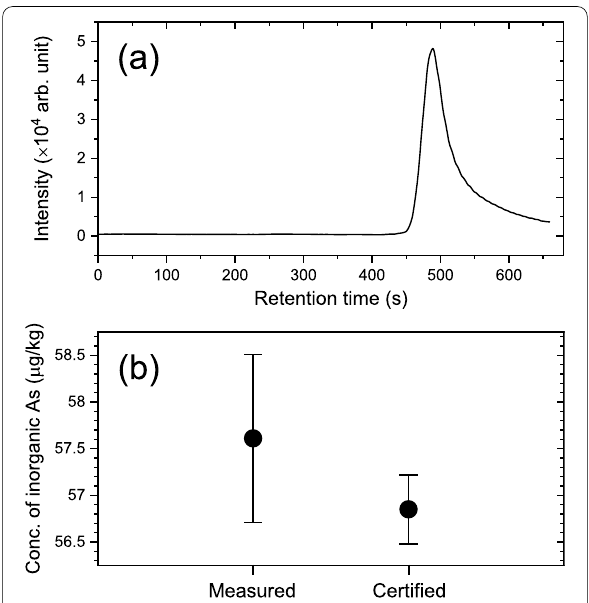
Fig. 5 a Chromatogram of arsenic species in human urine SRM and b the measured and certified concentrations of inorganic arsenic in human urine